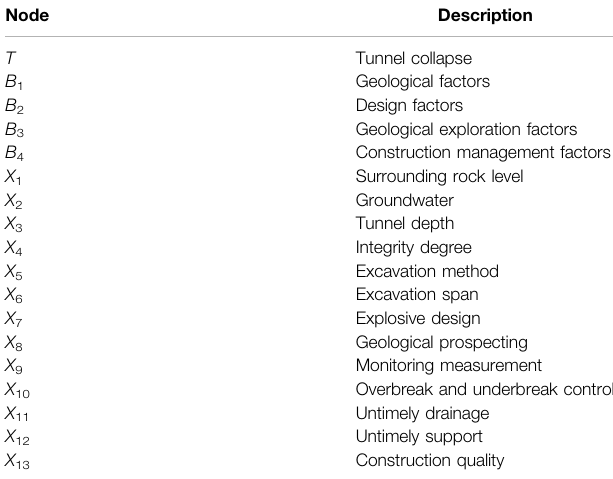
TABLE 2 | Descriptions of the nodes in the